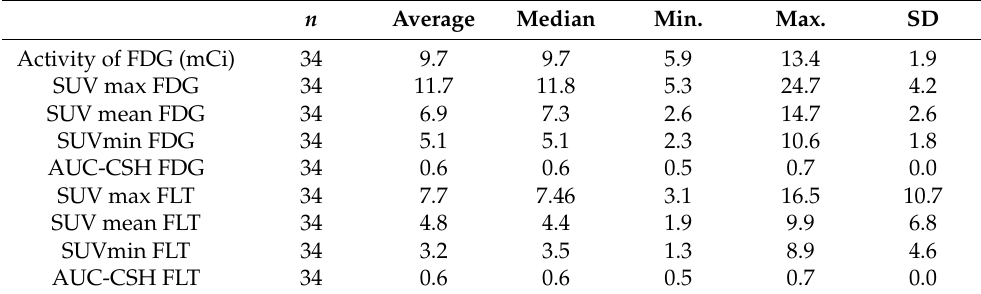
Table 3. The characteristics of PET CT parameters with 18F-fluorodeoxyglucose (FDG) and 18F- fluoro-deoxy-fluorothymidine